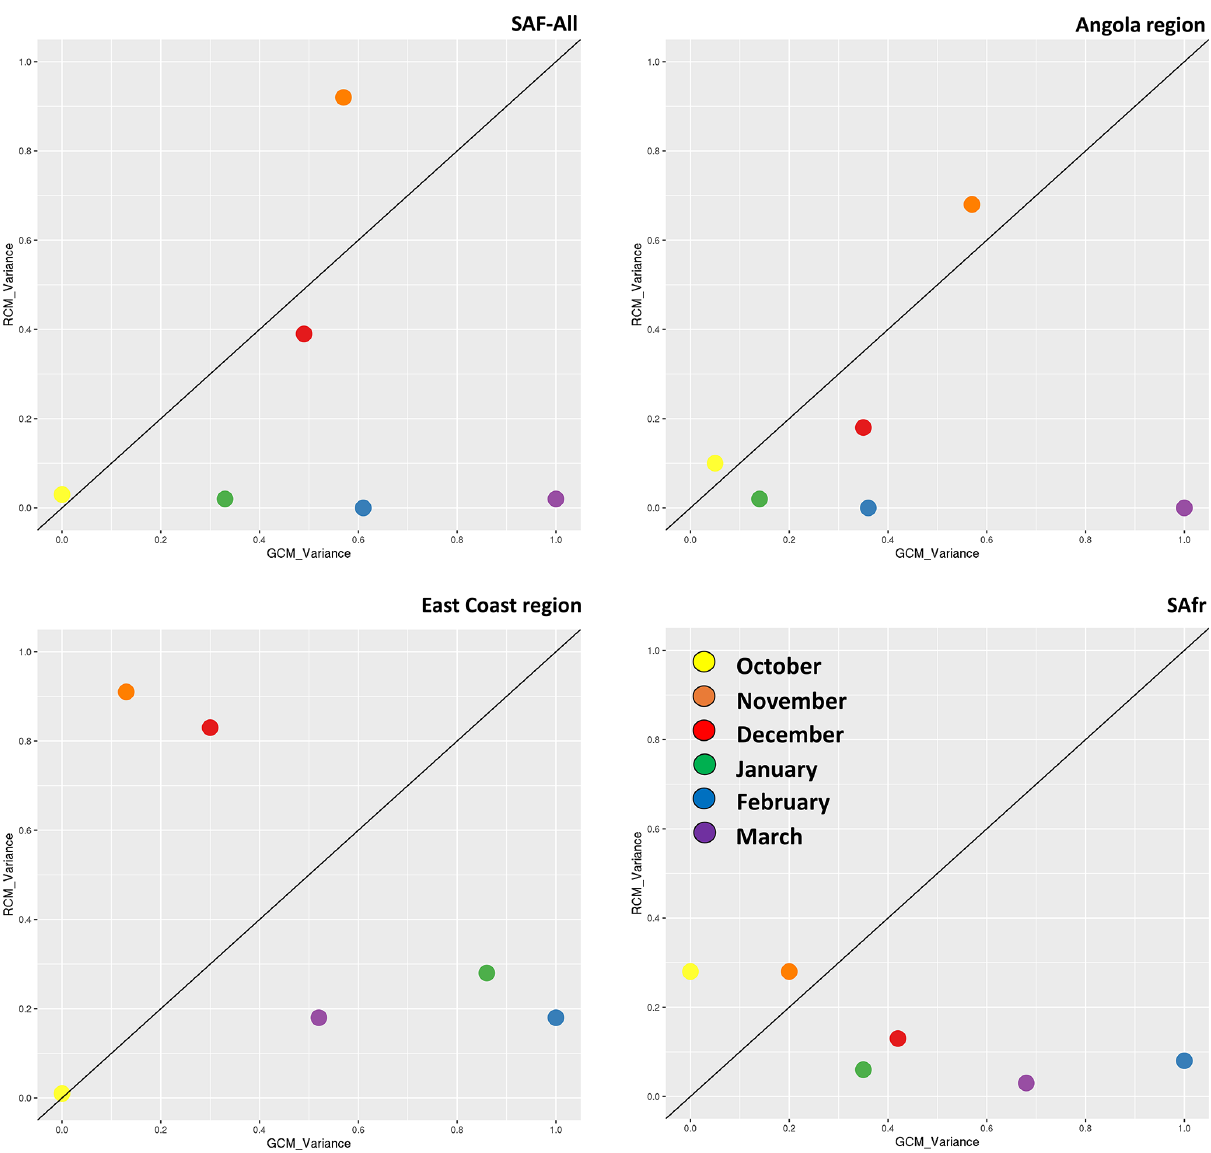
Figure 14. Analysis of the variance of monthly precipitation during 2065–2095 for southern Africa (SAF-All region) and the three sub- regions examined, namely the Angola region, East Coast region, and the SAfr region, respectively. The x and y axes display standardized precipitation